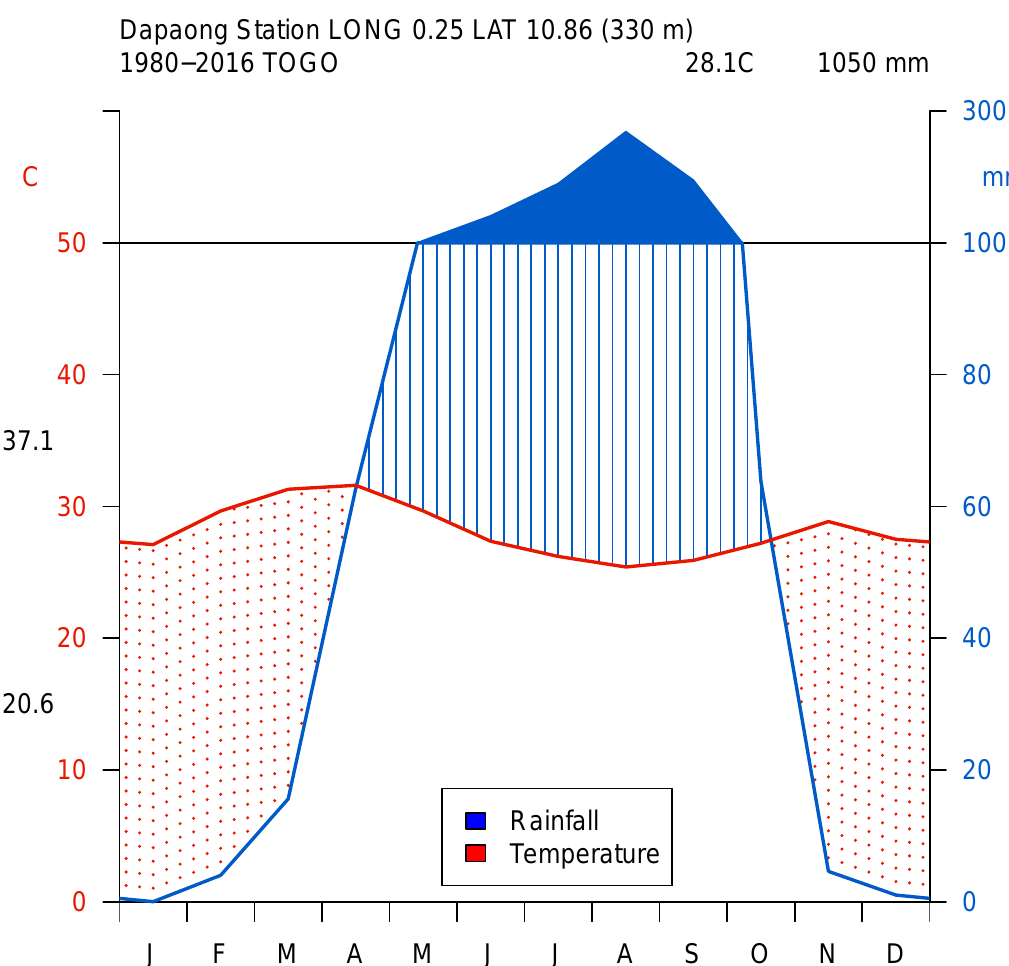
Figure 2. Walter–Lieth [55] climate diagram for northern Togo based on data collected at Dapaong Meteorological Station (Latitude: 10 ◦ 51 (cid:48) 44.10 (cid:48)(cid:48) N, Longitude: 0 ◦ 12 (cid:48) 27.43 (cid:48)(cid:48) E, Altitude: 330 m above sea level). Rainfall and temperature data were measured between 1980 and